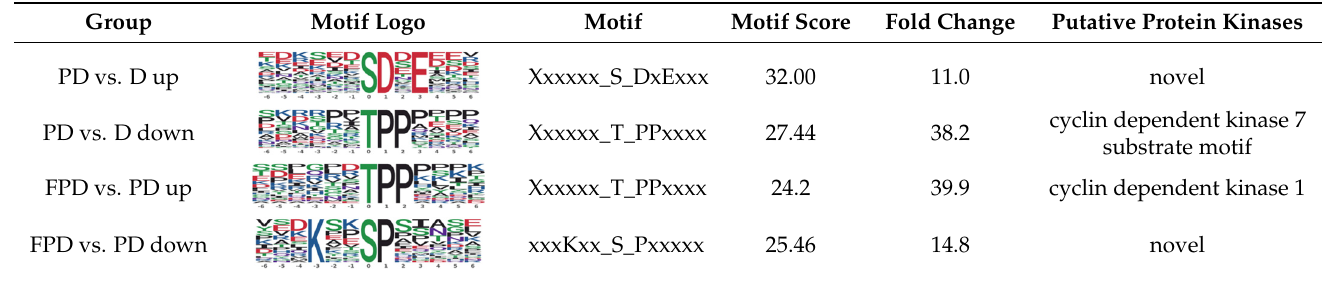
Table 3. The representative phosphorylation motifs on differentially expressed phosphopeptide sequences.